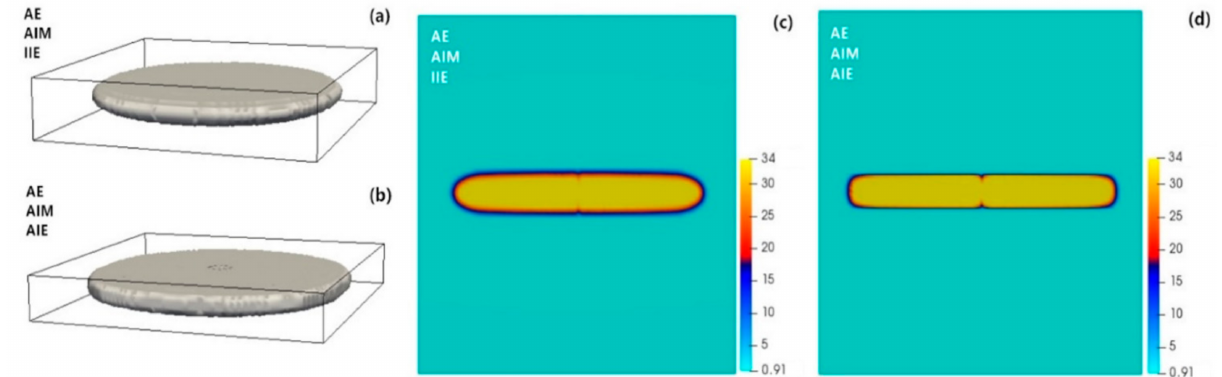
Figure 6. Three-dimensional view and 2D-cross section of a single θ (cid:48) precipitate with ( a , c ) AE, AIM and IIE conditions and ( b , d ) AE, AIM and AIE conditions in Al-1.69 at.% Cu alloy annealed at 453 K for t = 100,000 s. Here a 100 × 100 × 100 domain with grid spacing of ∆ x = 0.7 is used.